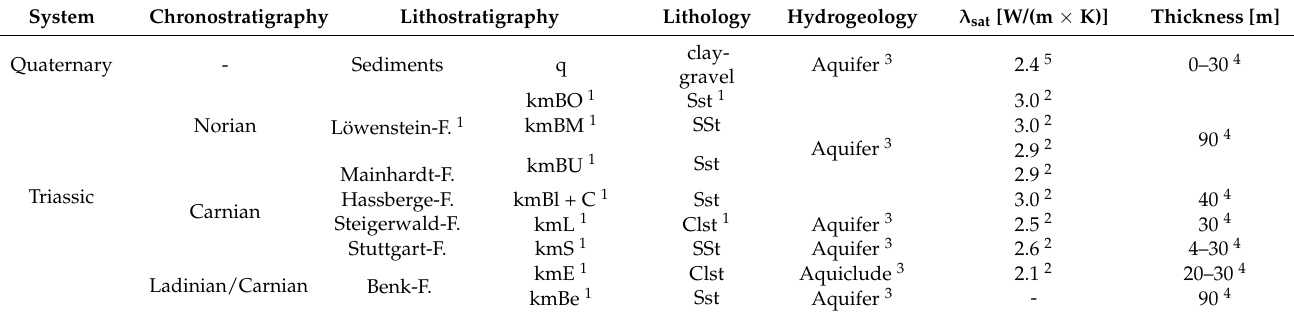
Table 1. Geological units of the Nuremberg subsurface with its hydraulic and thermal properties, modified after [45] and [25].